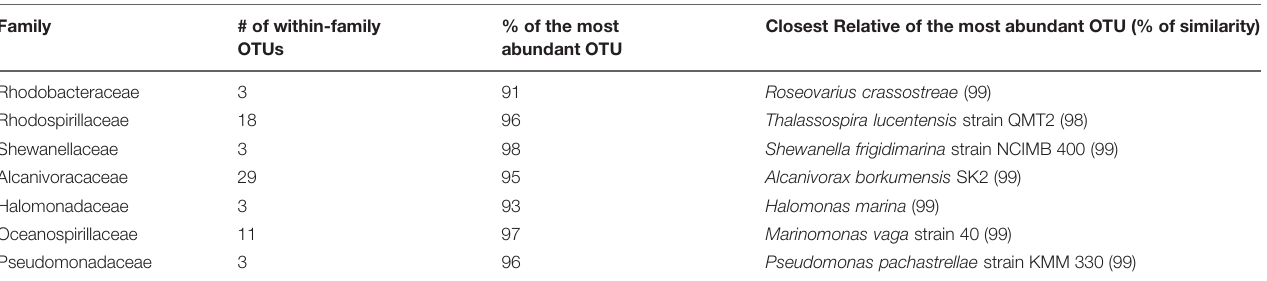
TABLE 2 | Within-family read distribution and closest relative of the most abundant